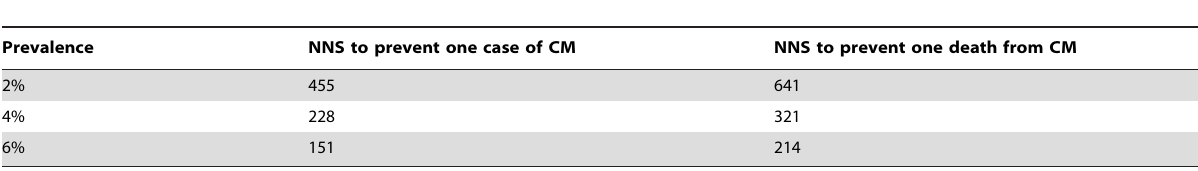
Table 4. Number Needed to Screen (NNS), by prevalence of serum CrAg-positive persons in Vietnam.